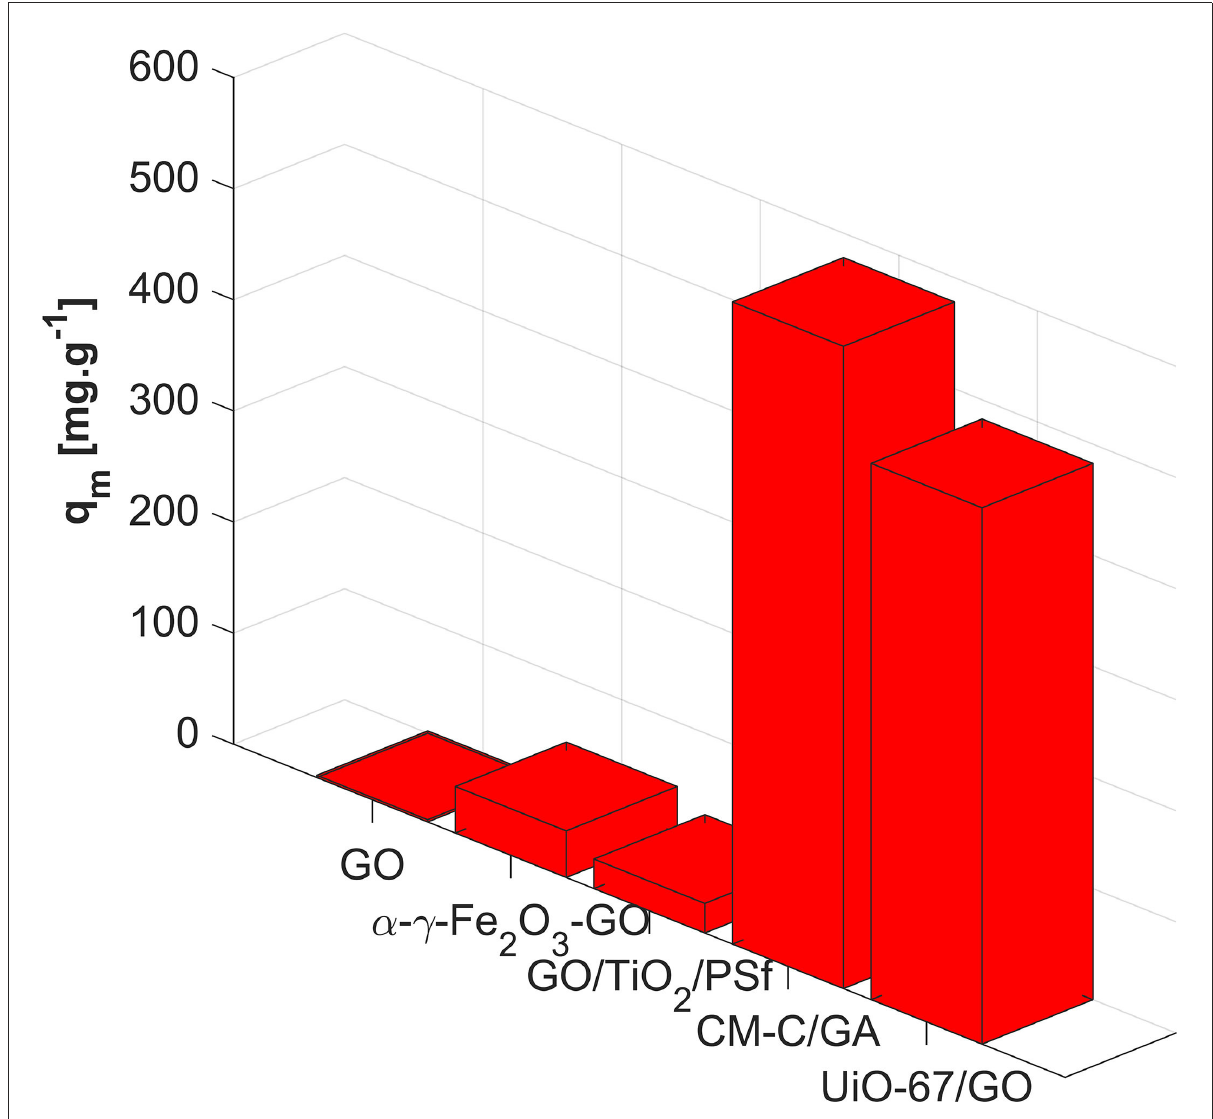
FIGURE3 Langmuir’s maximum adsorption capacity of GLY ( Q m ) of GO (Santos et al., 2019), magnetic GO (Santos et al., 2019), and non-magnetic GBM (Yang et al., 2017; Ding et al., 2018; Hosseini and Toosi,